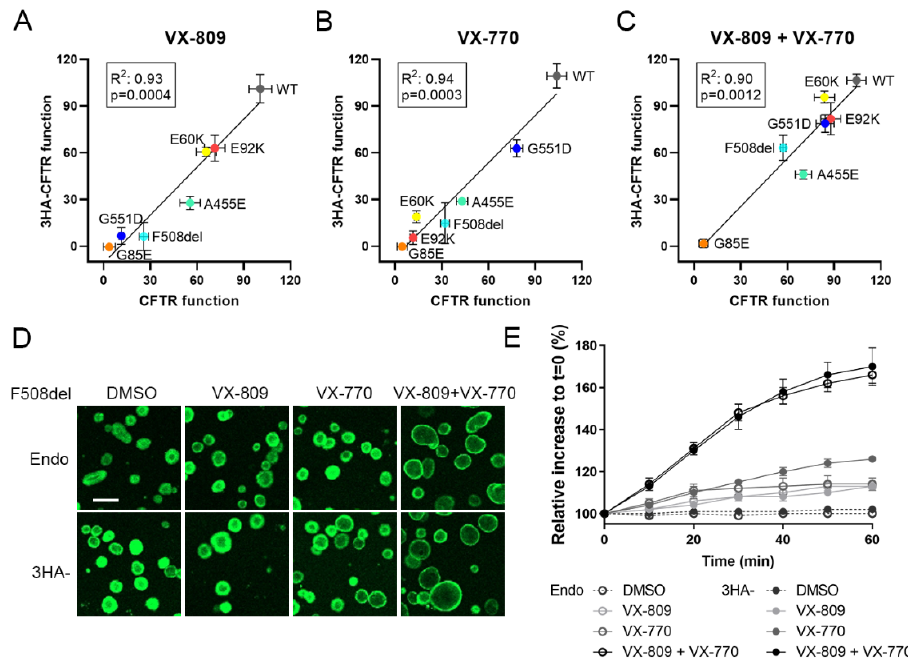
Figure 2. Study of the effect of tagging CFTR variants on CFTR function. ( A – C ) Pearson correlation of the rescue in CFTR function by corrector VX-809, potentiator VX-770 or the combination of both, of untagged and 3HA-tagged CFTR variants (for individual quantification, see Figure 3). HEK293T cells stably overexpressing CFTR variants were treated with 2.5 µM VX-809 for 24 h and/or 3 µM VX-770 for 20 min prior to determining CFTR function by HS-YFP quenching after stimulation with 10 µM forskolin (Fsk). Graphs depict the mean ± S.D. of three independent experiments. ( D , E ) Comparison of FIS responses of treated organoids with VX-809 (24 h, 2.5 µM), VX-770 (3 µM), VX-809+VX-770 or DMSO, all together with Fsk 5 µM. ( D ) Representative images of a FIS response for F508del/F508del CF organoids (top row, ‘Endo’; expressing endogenous F508del) and for CF organoids (genotype N1303K/3121-1G > A) stably overexpressing 3HA-F508del by LV transduction (bottom row, ‘3HA-‘), treated with DMSO, VX-809, VX-770 or both. Images represent t = 60 min after Fsk addition. Live organoids were visualized with calcein green. Scale bar = 200 µm. ( E ) Time course of both conditions over 60 min and responses to above CFTR modulators. A representative experiment is shown (n = 2 independent repeats). Mean ± S.D. of 4 wells per condition (~300 organoids/well). HS-YFP: halide sensitive yellow fluorescent protein, FIS: forskolin induced swelling, LV: lentiviral vector.